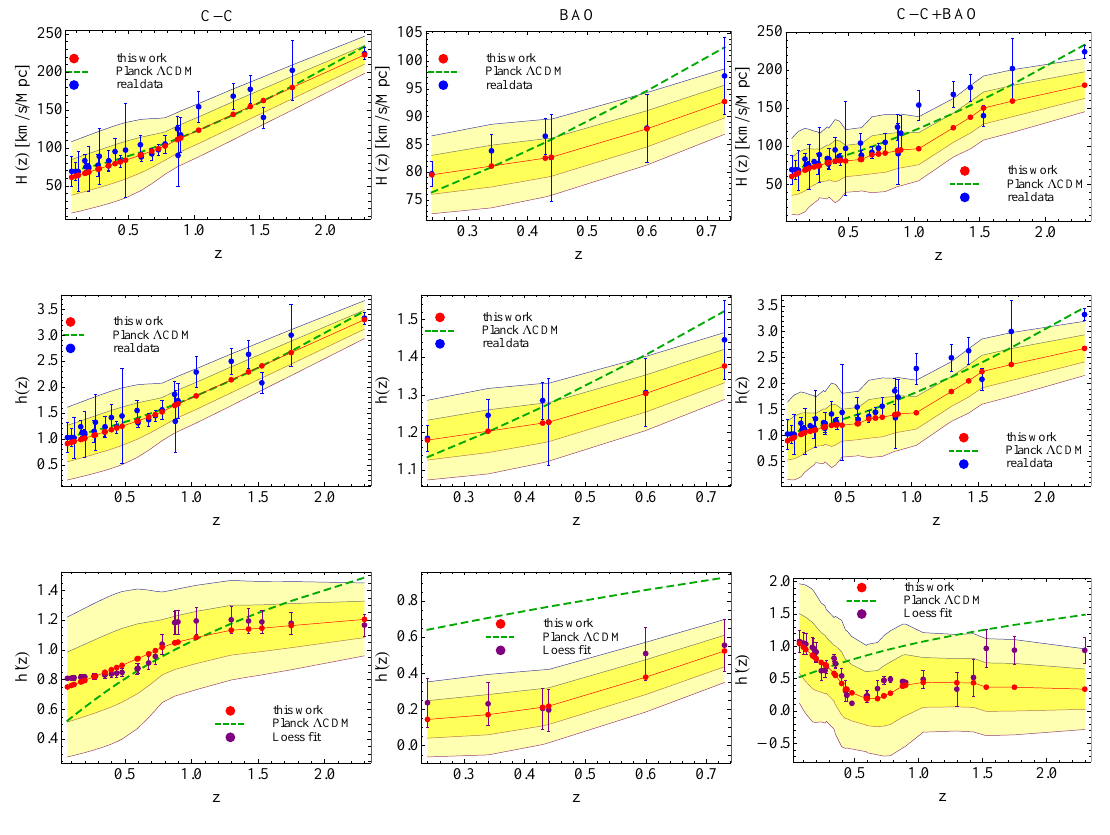
Figure 2. Reconstruction of H ( z ) , h ( z ) and h (cid:48) ( z ) parameters for C-C data ( left column), BAO data ( middle column) and C-C+BAO data ( right column). The red dots (line) are (is) the Loess–Simex results for each sample. The dashed green line is Λ CDM with Ω m = 0.315. Shaded yellow areas represent the 68% and 95% confidence regions. Top row: H ( z ) Loess–Simex reconstructions. The blue dots are the real data sample with its respective error bars; Middle row: h ( z ) Loess–Simex reconstructions. The blue dots represent the normalized real data h with its respective error propagation bars; Bottom row: h (cid:48) ( z ) Loess–Simex reconstructions. The purple dots represent the values of the second coefficient after performing a Loess routine fit, which also gives the uncertainty bars via the covariance